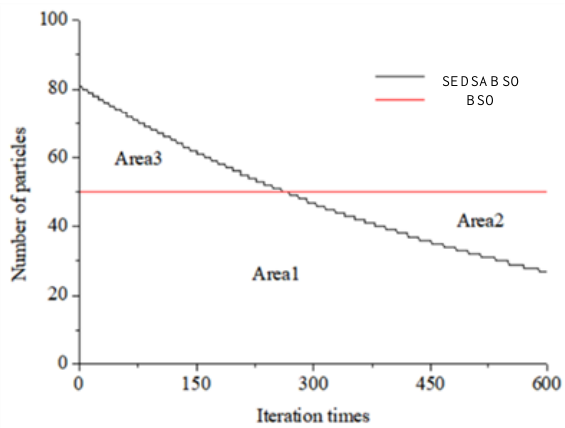
Figure 5. SEDSABSO and BSO Variation curve of number N of longicorn beetles.